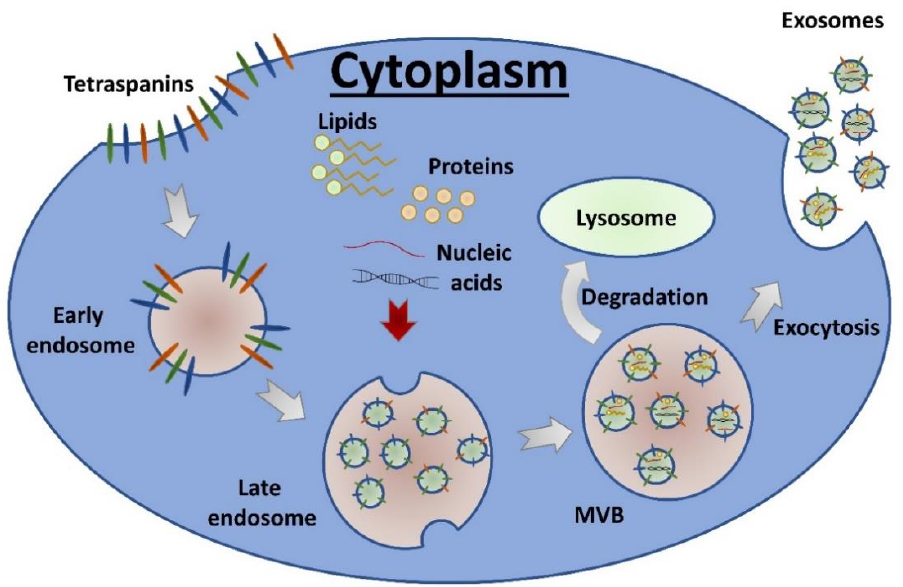
Figure 1. Biogenesis of exosomes.